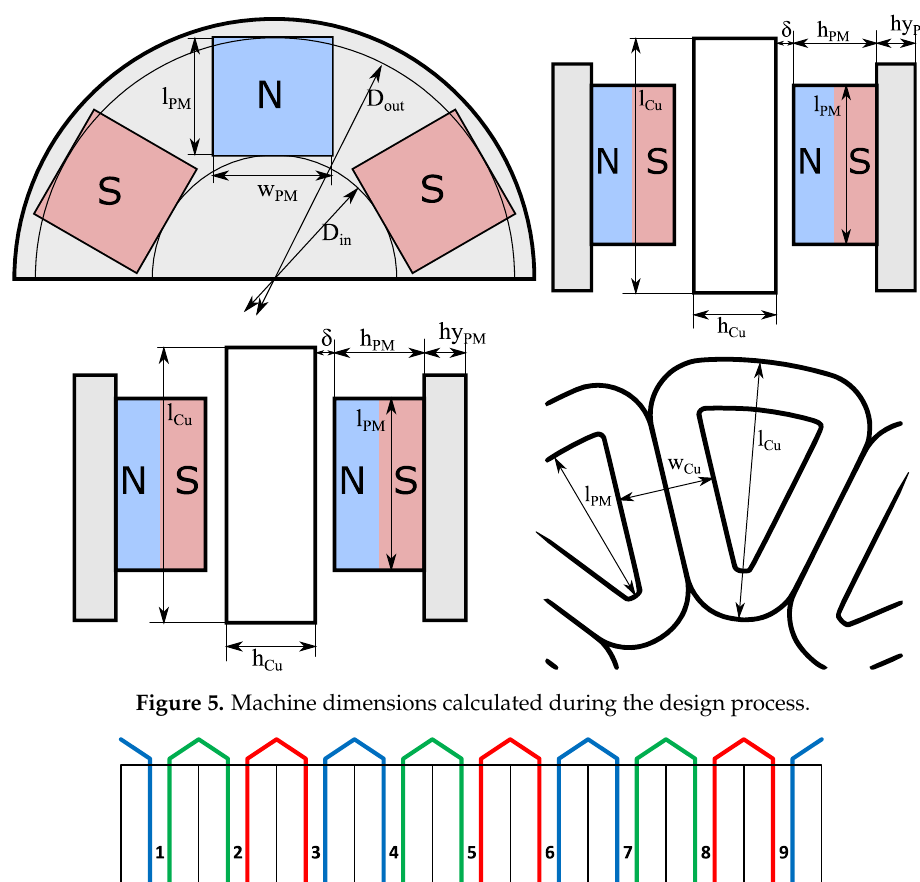
Figure 6. Concentrated winding of the designed machine.